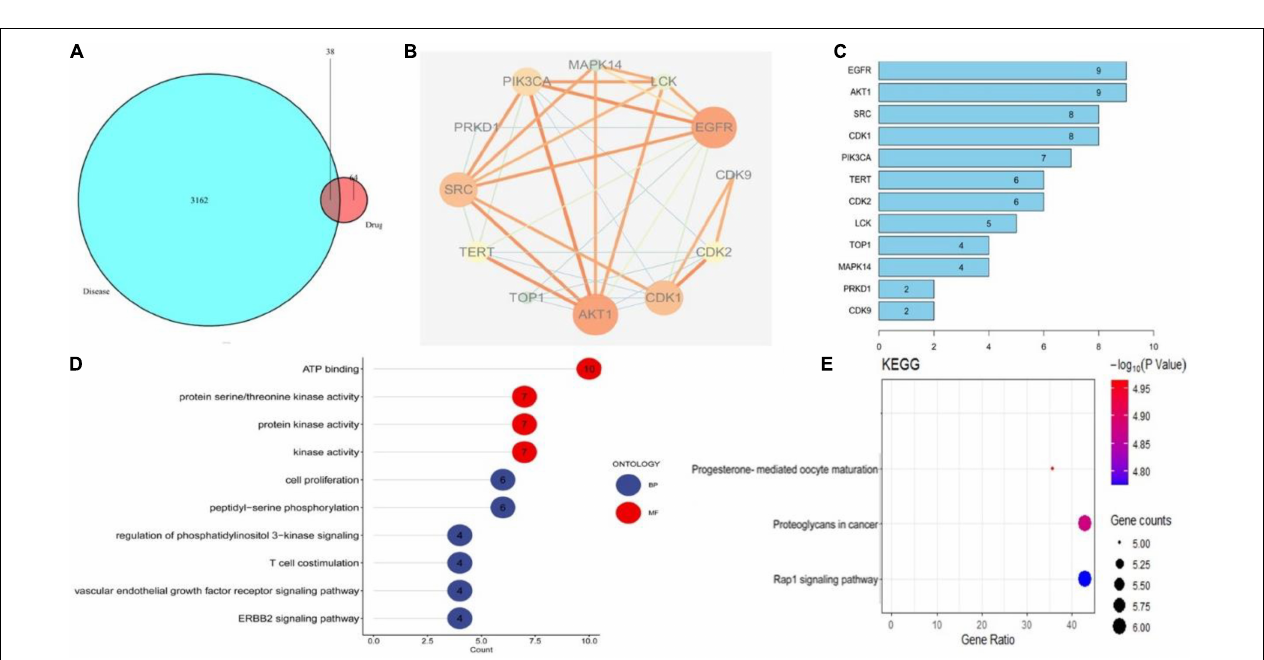
FIGURE 2 | CEP inhibits the transcription of genes associated with HSV-1 replication. Hela cells were mock-treated or treated with CEP at different concentrations, including 0.75, 1.5, and 3 µ g/mL for 24 h. The mRNA levels of ICP0 (A) , ICP4 (B) , ICP22 (C) , ICP8 (D) , TK (E) , and VP16 (F) were determined by qPCR analysis and represented as a fold change to mock-treated cells. Results from three independent experiments were quantitated and presented as means ± SD. ** P < 0.01; *** P < 0.001 indicates significant difference vs. model group.